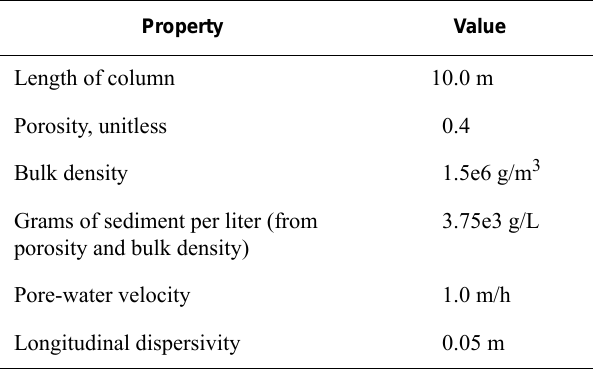
Table 38. Hydraulic and physical properties of the column in example